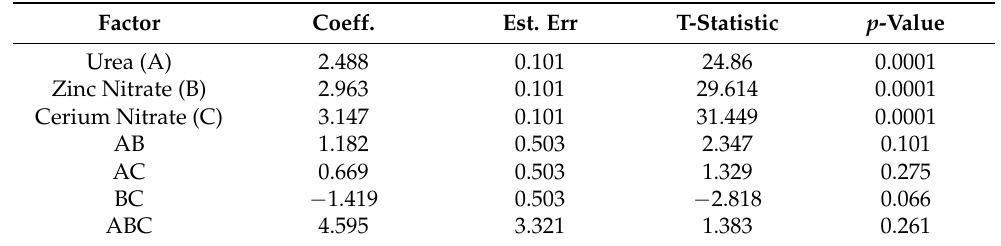
Table A2. Parameters of the Student’s test for evaluating the coefficients of the cubic model describing the Eg.